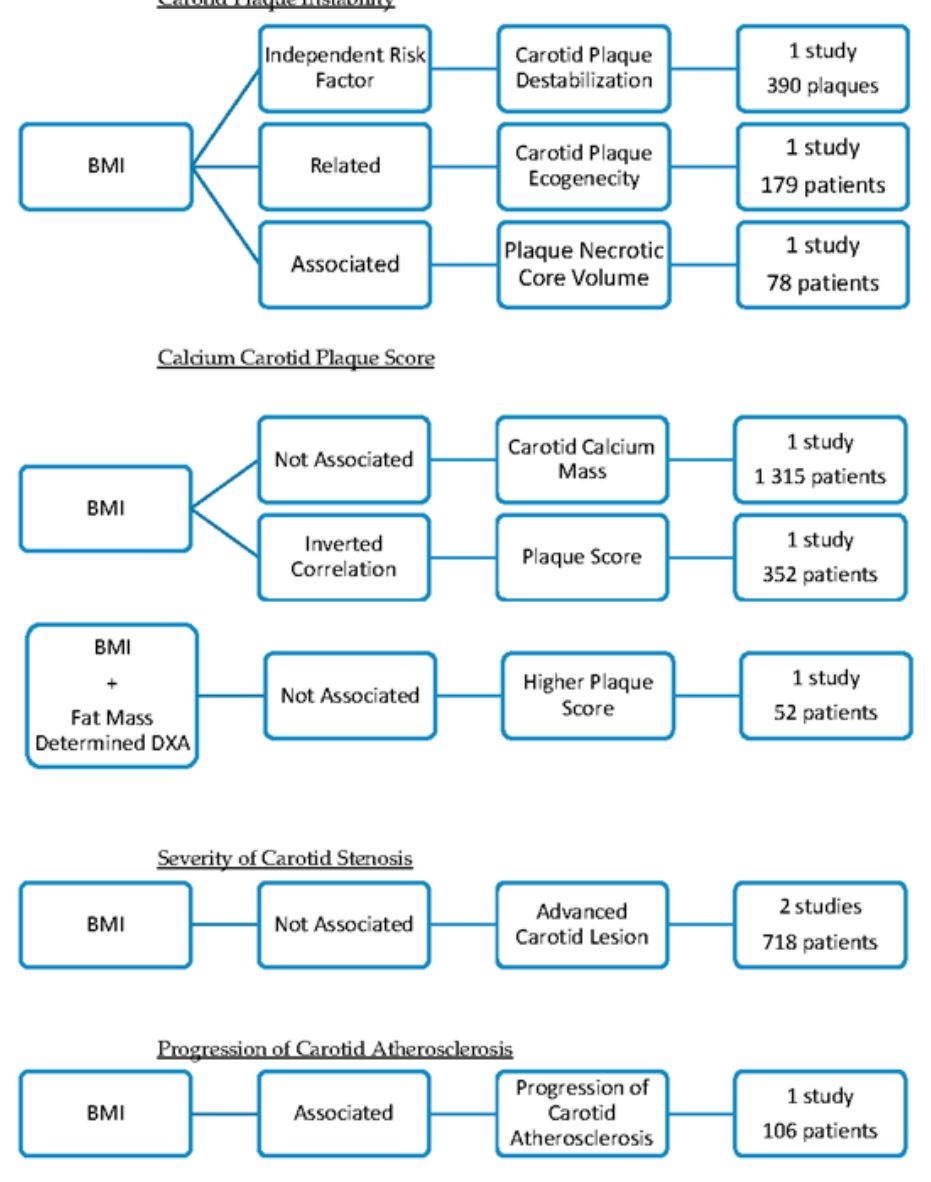
Figure 3. Summary of the studies that correlate overall obesity with the characteristics of the carotid atherosclerotic